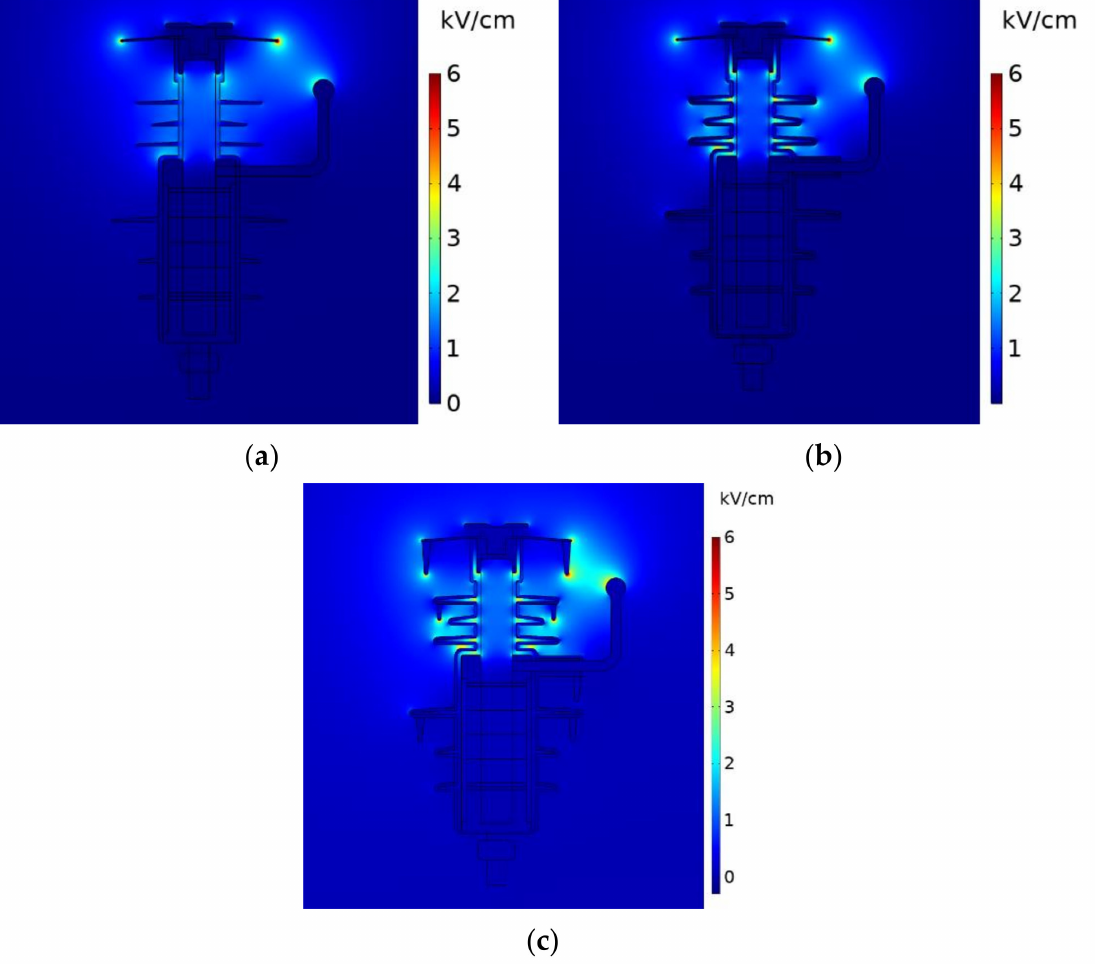
Figure 5. Electric field distribution of the novel lightning protection insulator under icing conditions: ( a ) Electric field distribution of a clean insulator; ( b ) Electric field distribution of an insulator with the ice layer without icicles; ( c ) Electric field distribution of an insulator with the ice layer with